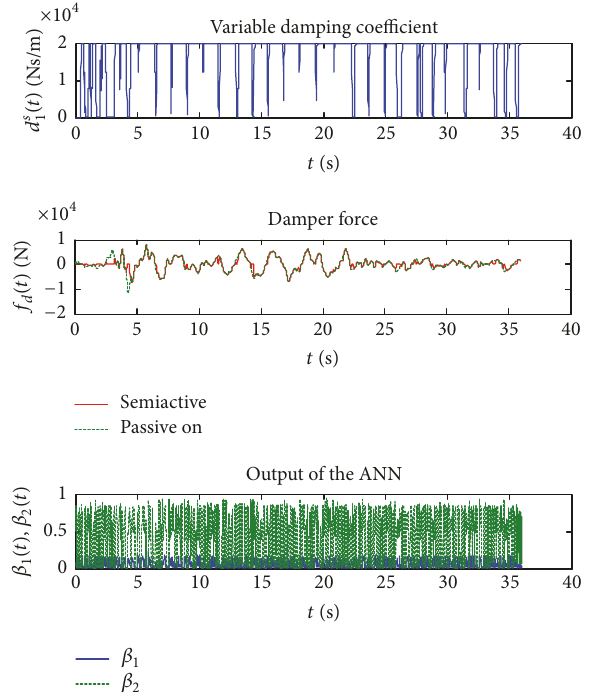
Figure 15: Simulation results for the Hachinohe NS (1968) earth- quake disturbance; variable damping coefficient 𝑑 𝑠 1 (𝑡) , force of damper 𝑓 𝑑 (𝑡) , and output signals of the ANN 𝛽 1 (𝑡) and 𝛽 2 (𝑡)